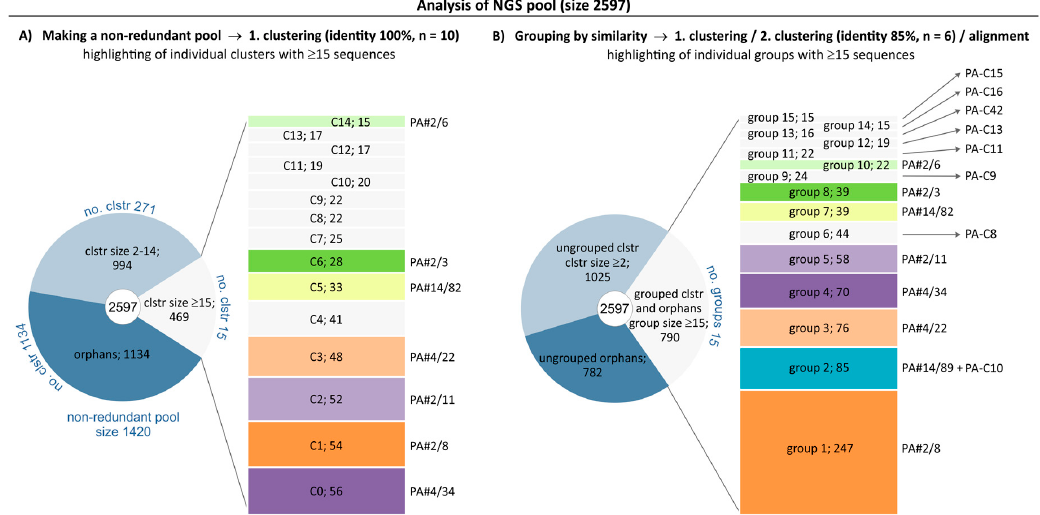
Figure 2. Selected pool of Protein A-binding aptamers after direct sequencing. Results of data analysis of the NGS pool containing 2597 sequences are shown. ( A ) First clustering of identical sequences resulted in a non-redundant pool of 1420 sequences (see also Figure S2). Clusters with a size of ≥ 15 sequences are highlighted (C0–C14) with the number of sequences included. Identified sequences from the Sanger data pool are indicated; ( B ) Second clustering (85% identity) of the non-redundant pool and a final alignment resulted in groups of sequences from the NGS pool with respect to their identity and similarity. Groups with a size of ≥ 15 sequences are highlighted (group 1–15) with the number of sequences included, which also determine the rank position of the group. The representative of each group is indicated and corresponds to the most frequent sequence in the group. It is named according to a known sequence from the Sanger data pool if identified or according to the cluster name from the non-redundant pool in case of new sequences.